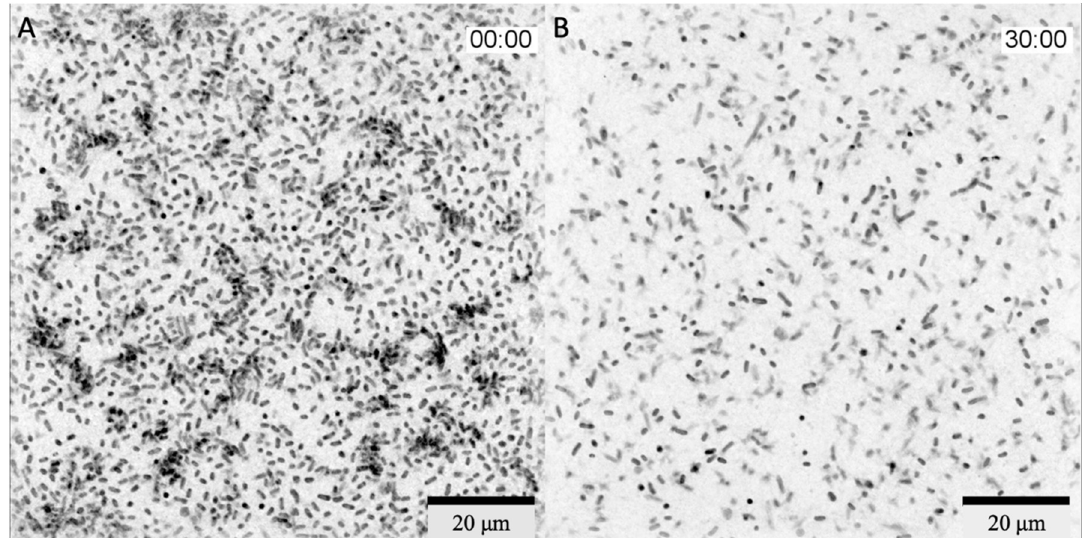
Figure 2. 3D Cell Explorer micrographs of K. pneumoniae (Kl 315) culture: ( A ) 2 h 30 min; ( B ) 3 h after the addition of the bacteriophage cocktail. Magnification ×58, scale bar 20 μ m. The experiment was conducted in one repetition.